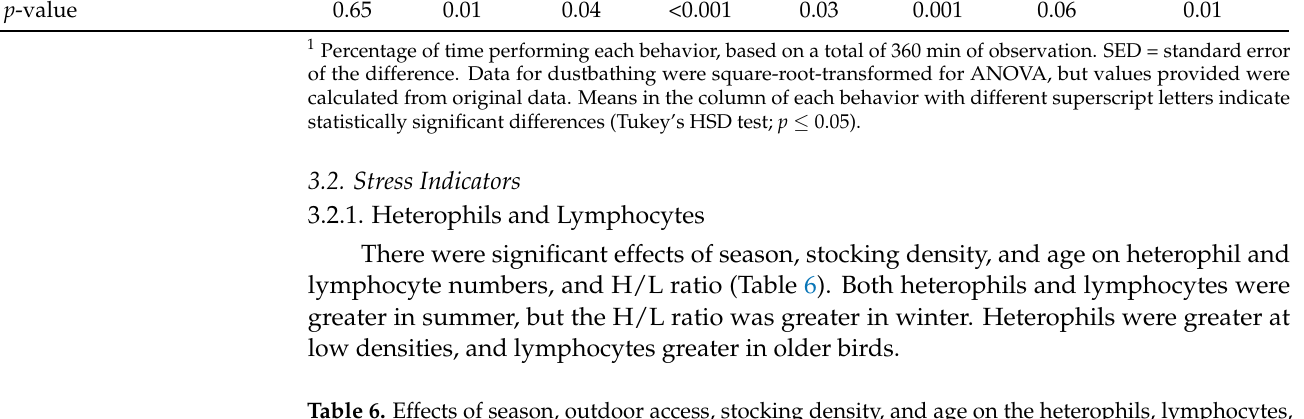
Table 6. Effects of season, outdoor access, stocking density, and age on the heterophils, lymphocytes, and H/L ratio of Cobb500 broilers 1